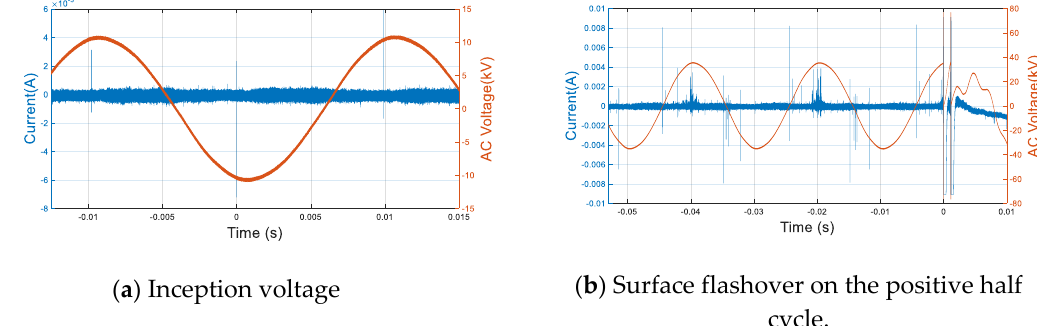
Figure 15. Voltage-current waveform for measuring surface discharges events (4%Novec TM 4710 / 96%CO 2 , PTFE, Needle on HV electrode, 1 bar abs).